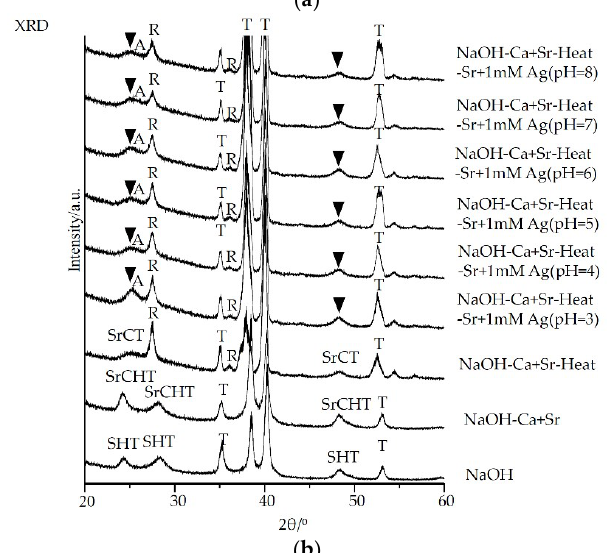
Figure 1. Raman ( a ) and XRD ( b ) spectra of Ti surfaces subjected to Sr + 1 mM Ag treatment with various pH following NaOH, Ca + Sr and heat treatment.